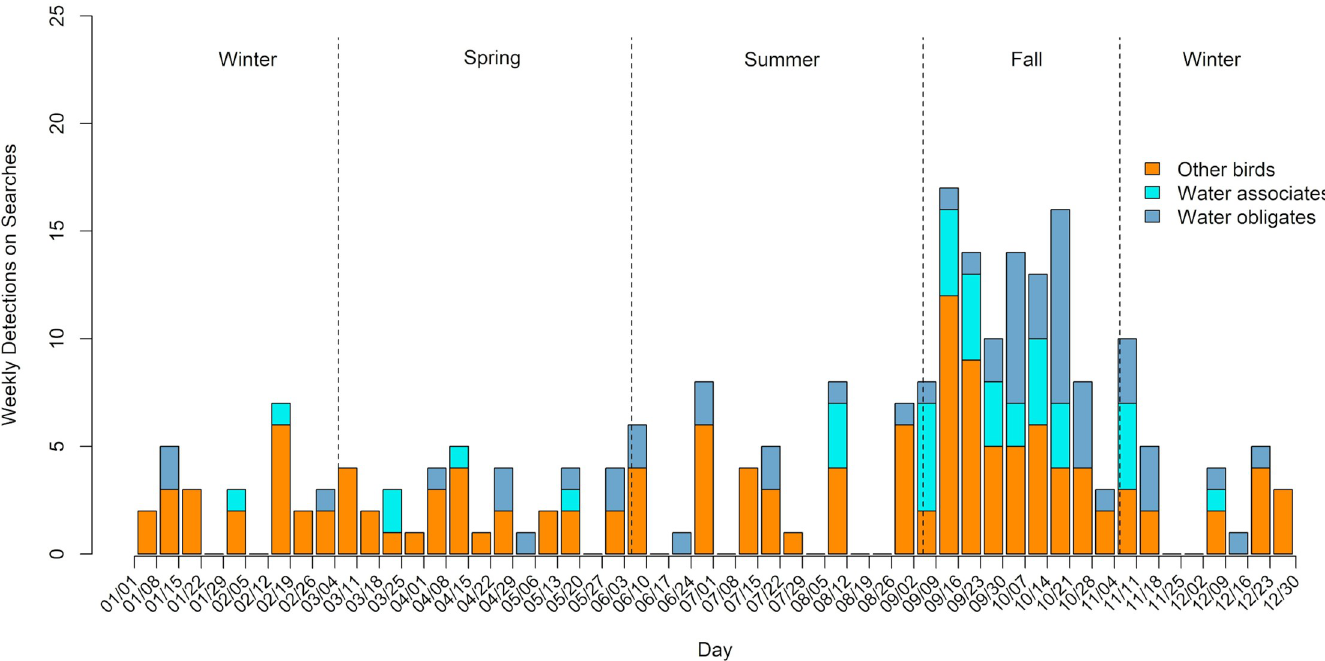
Fig 2. Phenology of avian detections found during standardized monitoring in the photovoltaic solar field at 7 sites from January 1, 2013, to September 1, 2018 in the Sonoran and Mojave Deserts and Great Basin Bird Conservation Regions. Water associates are species that rely on water for foraging, reproduction, and/or roosting; water obligates are species that cannot take flight from land; other birds are species not falling into either of those categories.